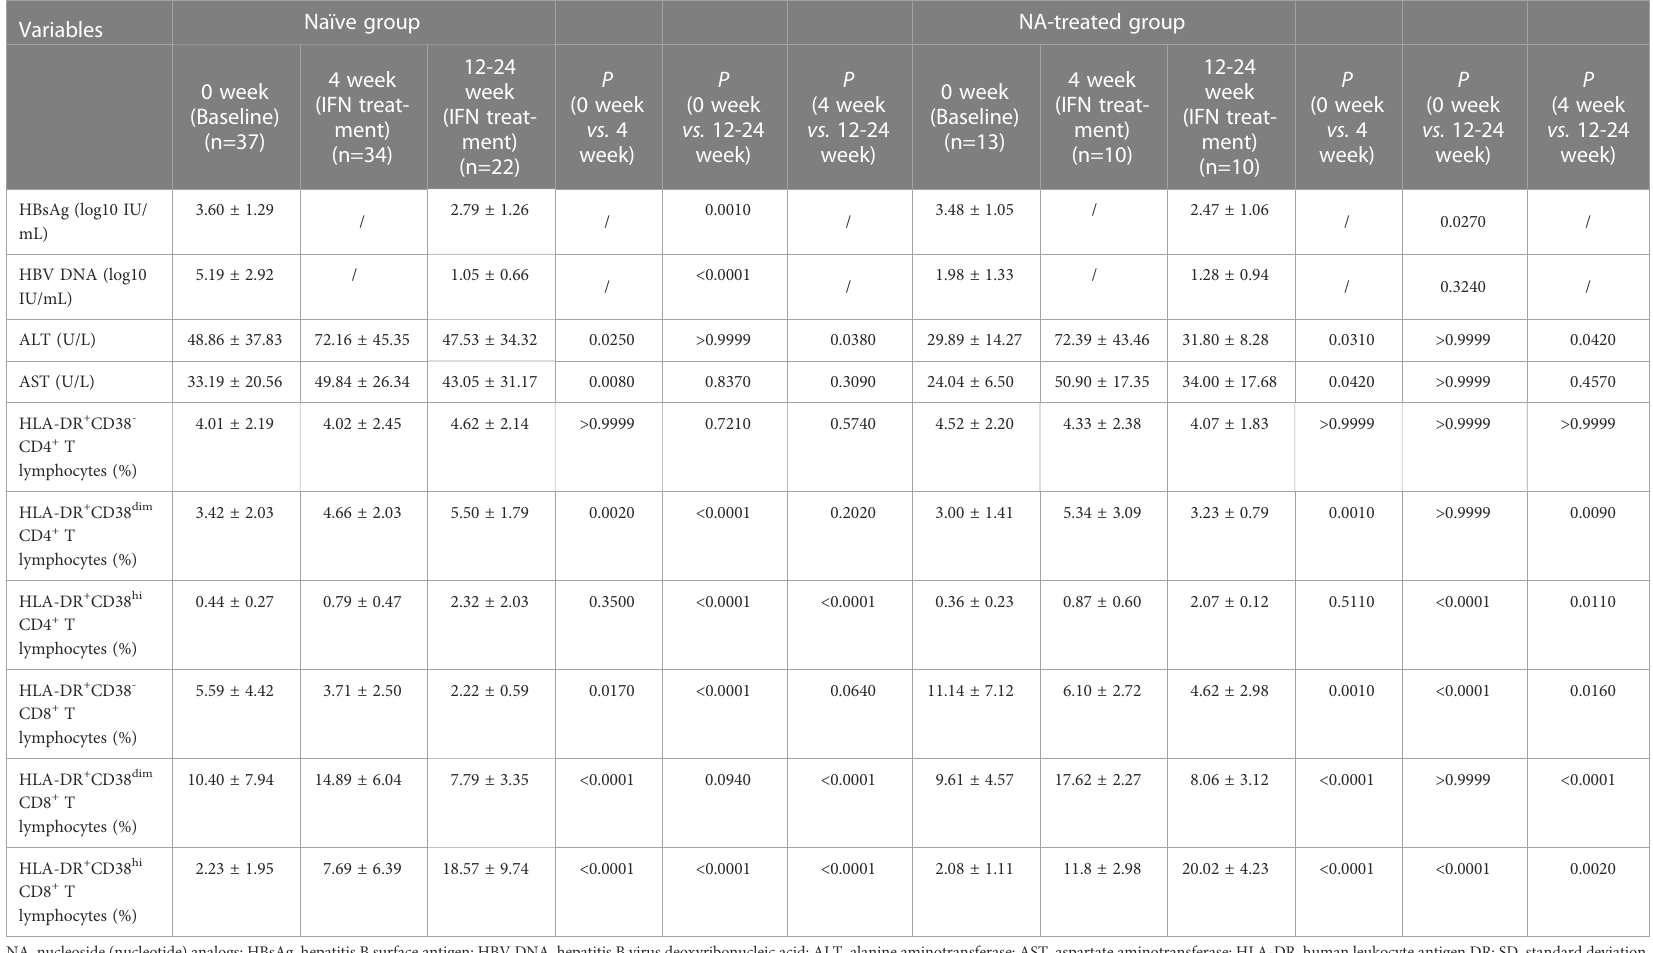
TABLE 2 The changes of indicators in each group during IFN treatment a .